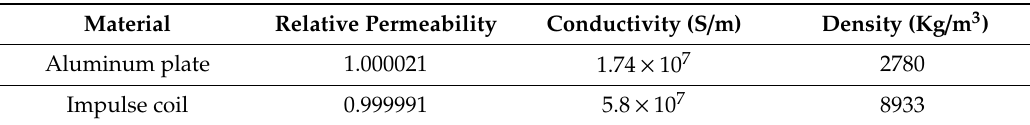
Table 1. Material characteristics.